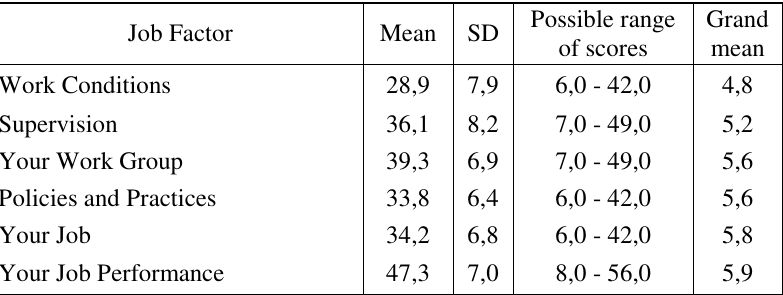
MEAN SCORE ON JOB FACTOR